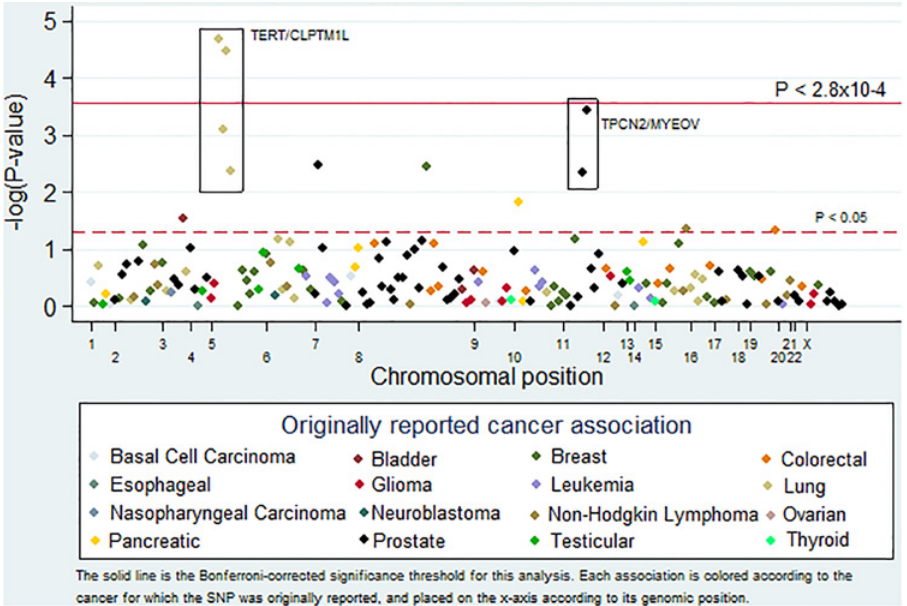
Fig 1. Pleiotropy-colored Manhattan plot. This plot shows the inverse log of the P-value for the association between melanoma and SNPs previously associated with cancer. The solid line represents the Bonferroni- corrected significance threshold for this analysis (0.05/181 = 2.8x10 -4 ). Each association is colored according to the cancer for which the SNP was originally reported, and placed on the x-axis according to its genomic